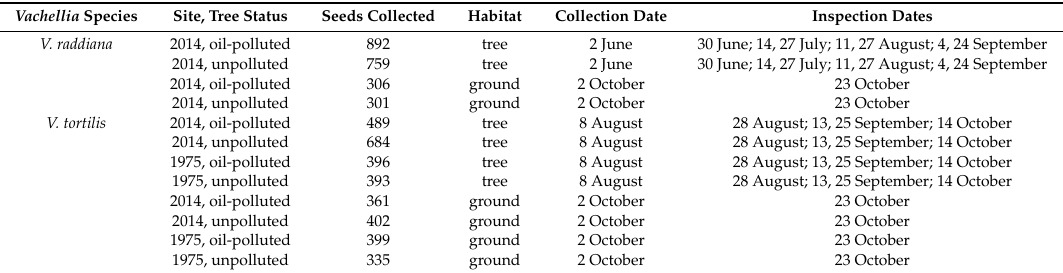
Table 1. Number of seeds collected per each Vachellia tree species, site, tree status, and habitat in Evrona Nature Reserve, southern Israel, during the field season 2019. Inspection dates are the dates on which seeds were examined for the presence of holes and emerging beetles were